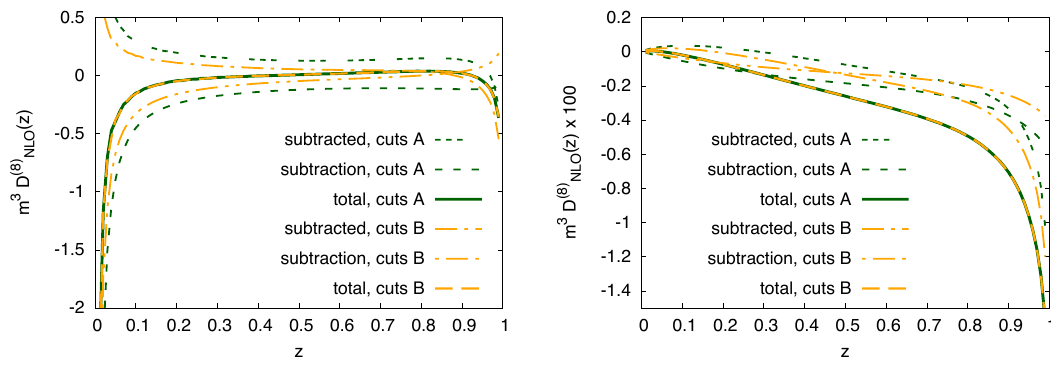
Figure 3 . The (cid:12)nite parts of the real contributions to the NLO fragmentation function D (8) The fragmentation function with n f = 0 and the coe(cid:14)cient of n f in the fragmentation function are shown in the left panel and in the right panel, respectively. The subtracted and subtraction contributions are associated with the decomposition in eq. (3.19). Cuts A and B refer to the two sets of cut parameters speci(cid:12)ed in eqs. (3.52a) and (3.52b). The \total" curves for cuts A and cuts B are almost